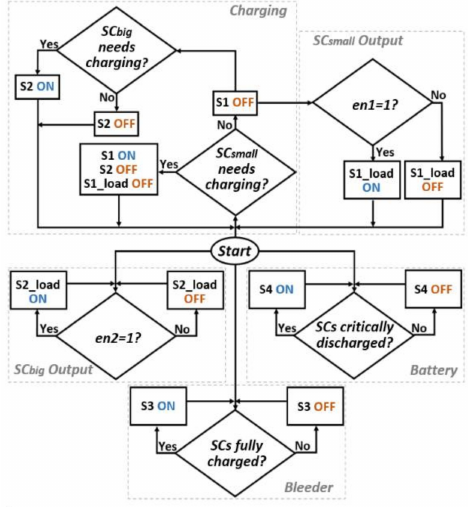
Figure 3. A flowchart of the proposed system operational